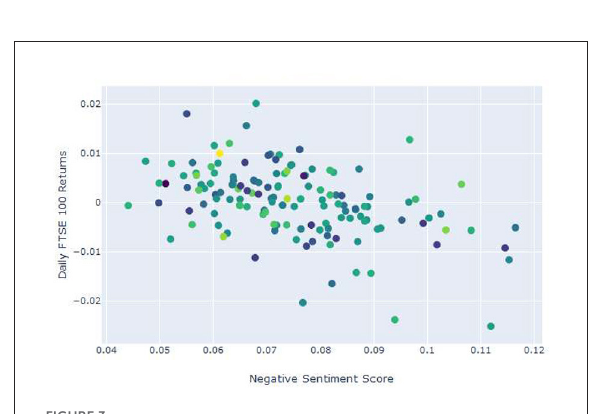
FIGURE3 Headlines dataset: The scatterplot shows the linear relationship between negative sentiment and